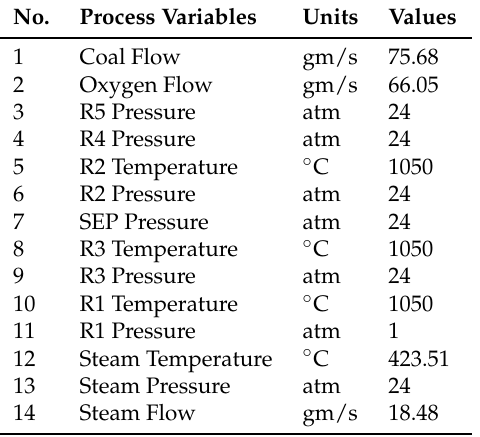
Table 4. Process variables used for soft-sensor development.